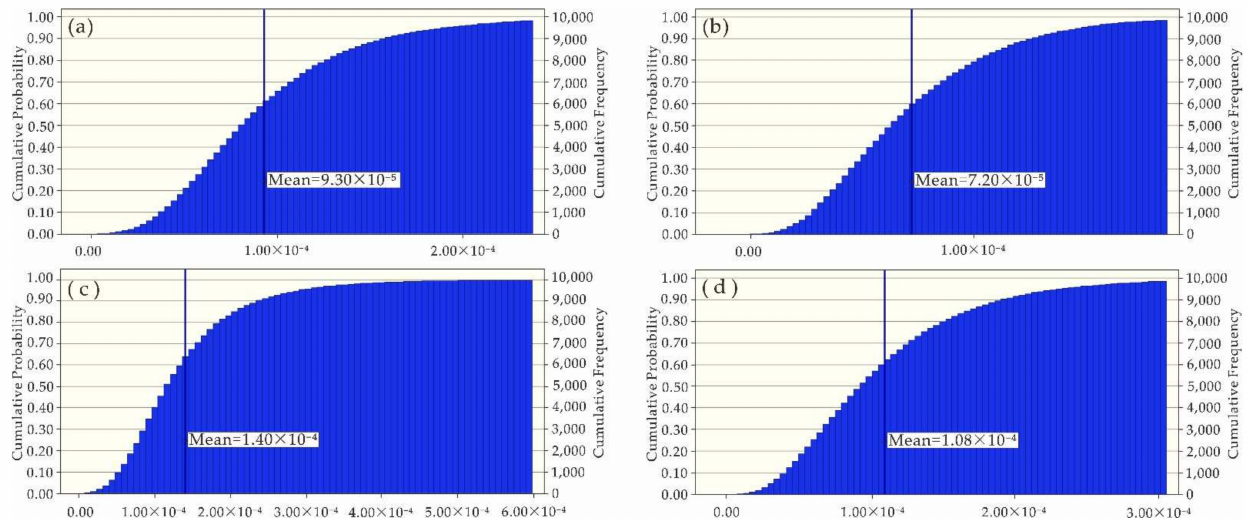
Figure 7. Simulated CR (As) values of ( a ) adults on the left bank; ( b ) adults on the right bank; ( c ) kids on the left bank; and ( d ) kids on the right